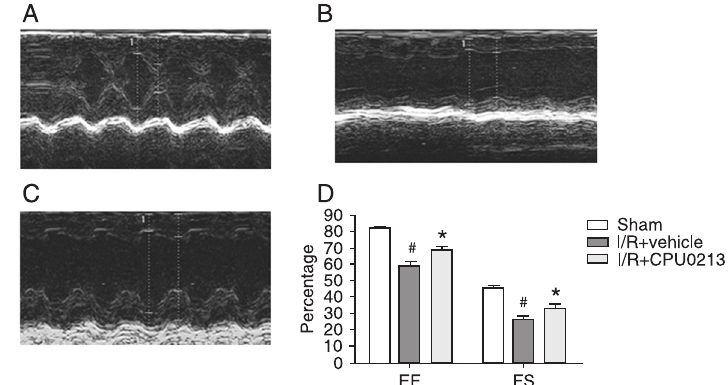
Figure 3. Cardiac function examined by echocardiography after ischemia-reper- fusion. Representative M-mode echocardiographs of Sham ( A ), I/R + vehicle ( B ), and I/R + CPU0213 groups ( C ). D , CPU0213 pretreatment increased ejection fraction (EF) and fractional shortening (FS) compared to the I/R + vehicle group. I/R = ischemia/reperfusion. Data are reported as means ± SEM for 7 rats/group. # P < 0.001 vs Sham, *P < 0.05 vs I/R + vehicle (one-way ANOVA followed by the Bonferroni post hoc test).